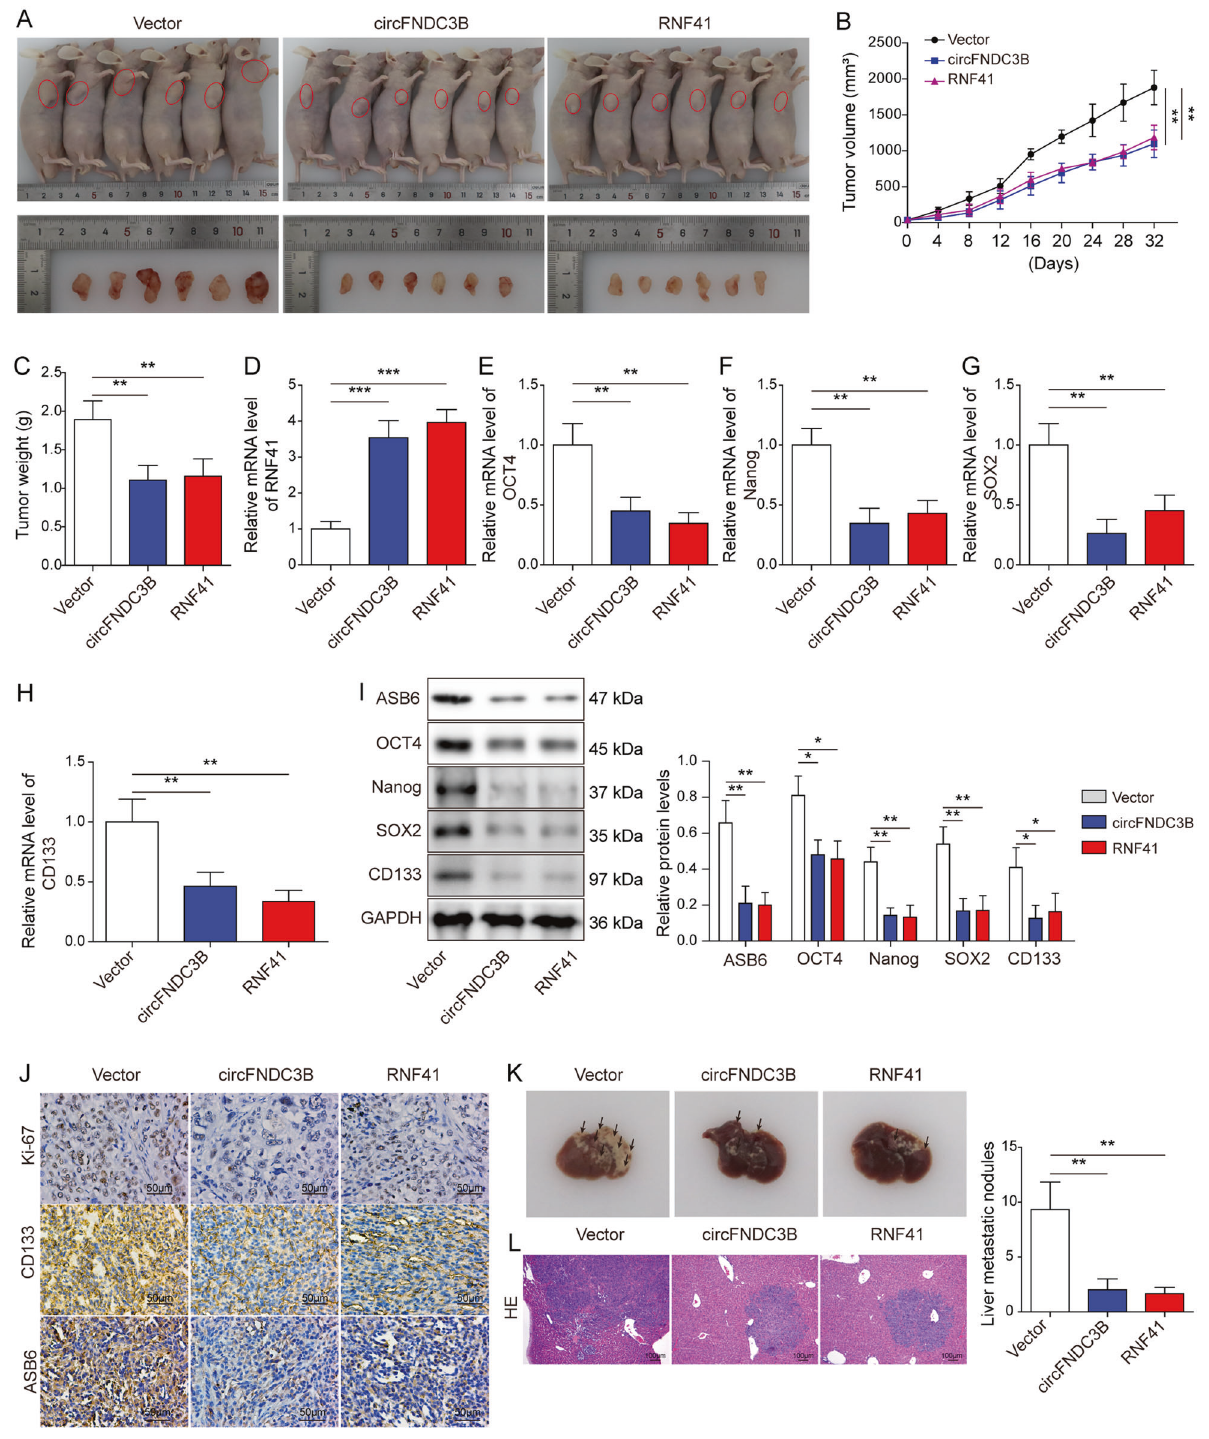
Fig. 9 Overexpression of circFNDC3B or RNF41 suppresses tumor growth, stemness and liver metastasis via modulating ASB6 in vivo. A Photographs of xenograft tumors. B Quantitative analysis of tumor volume. C Quantitative analysis of tumor weight. D – H The mRNA levels of RNF41, OCT4, Nanog, SOX2, and CD133 in xenograft tumors were detected by qRT-PCR. I The protein levels of ASB6, OCT4, Nanog, SOX2, and CD133 were detected by western blotting with quantitative analysis. J The immunoreactivities of Ki-67, CD133, and ASB6 in xenograft tumors were detected by IHC analysis. K Representative photographs of liver tissues derived from in vivo liver metastasis mice model. L The histological changes of liver tissues were detected by H&E staining. * P < 0.05, ** P < 0.01, *** P < 0.001.